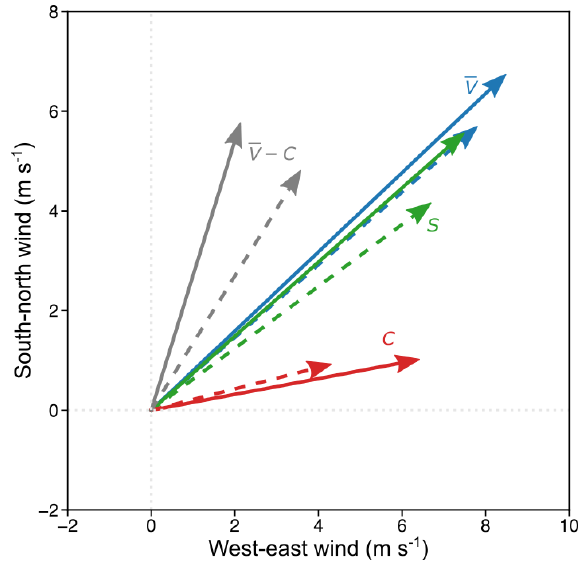
Figure 11. Wind vectors related to the intensification of the supercell at 1318 (dashed lines) and 1354 (solid lines) LTC, respectively. The grey ones represent the storm-relative winds ( V − C ), the blue ones represent the 0–6 km mean horizontal winds ( V ), the green ones represent the 0–3 km mean VWSs ( S ), and the red ones represent the mean translation vectors of the supercell updraft ( C ). Table 3. The local environmental factors based on the VWPs in Figure 11, including the 0–1 (VWS 0–1 ), 0–3 (VWS 0–3 ), and the 0–6 (VWS 0–6 ) km vertical wind shear, and the 0–1 (SRH 0–1 ) and 0–3 (SRH 0–3 ) km storm-relative helicity.